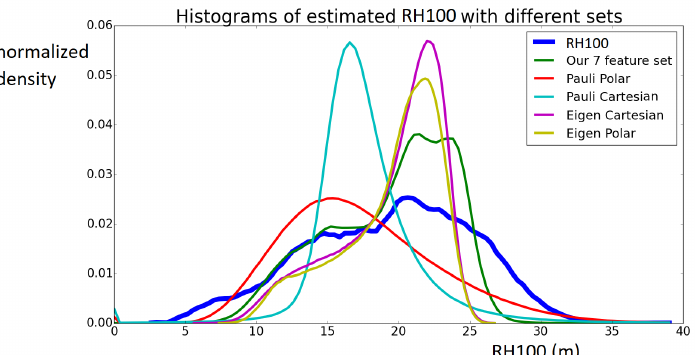
Figure 17. Histograms of estimated Rh100 with different